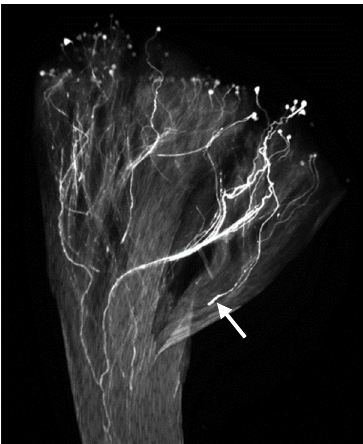
Figure 3. Morphology of P. axillaris axillaris pollen tubes growing in P. integrifolia pistils for 24 h. The arrow points to the dilated tips with heavy sub-terminal deposits of callose.